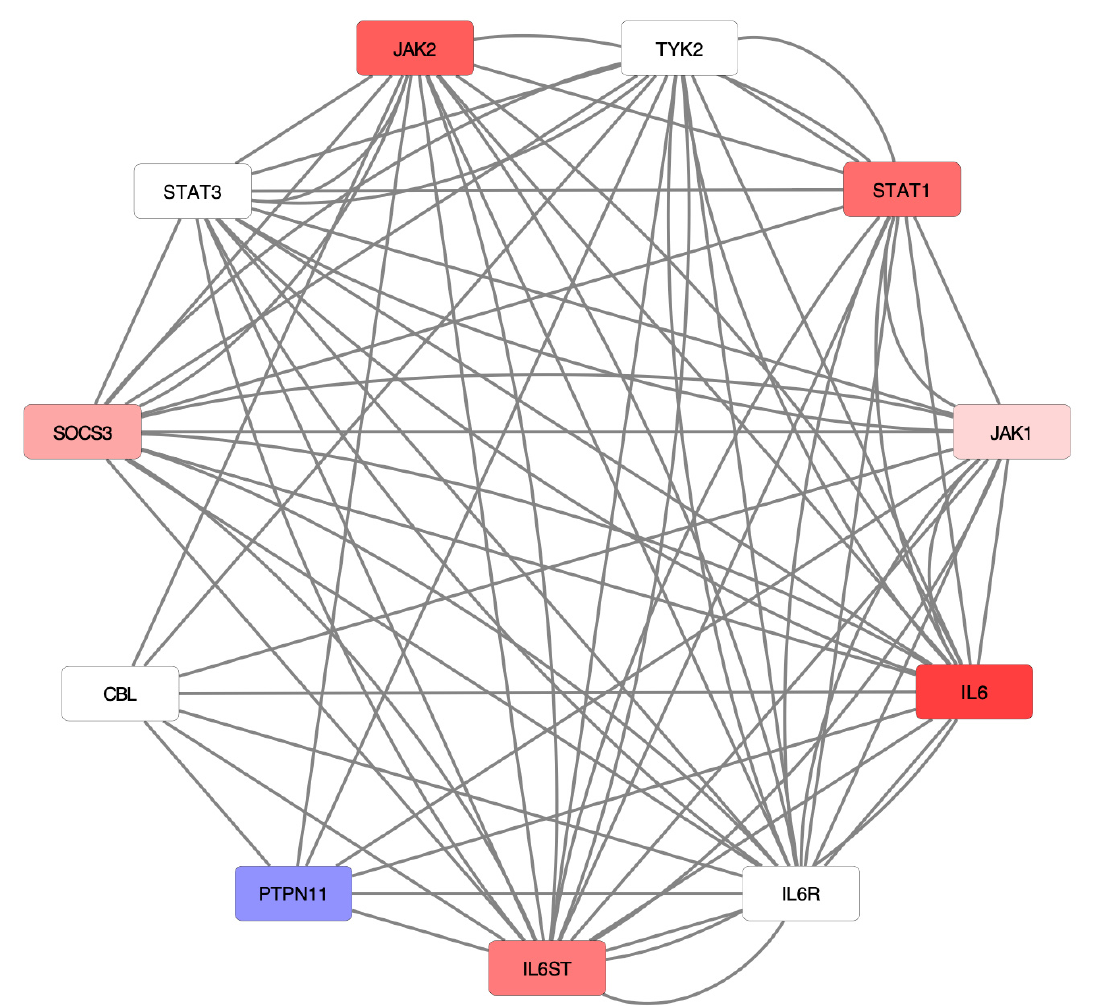
Figure 2. Infection with SARS-CoV-2 shows differential gene expression in Interleukin-6 signaling. This signaling pathway is a component of the larger Cytokine Signaling in Immune System pathway in Reactome. Each node represents a protein in the network, while each edge represents a characterized interaction between the proteins. Higher log2 fold-change values (up-regulation) are represented by increasing saturation of red, while more negative log2-fold-change values (down-regulation) are colored with increased saturation of blue. White nodes indicate no measured log2-fold